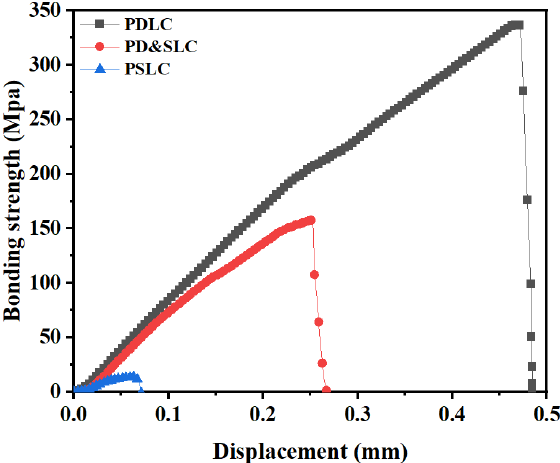
Figure 10. Bonding strength of PDLC, PD&SLC and PSLC.